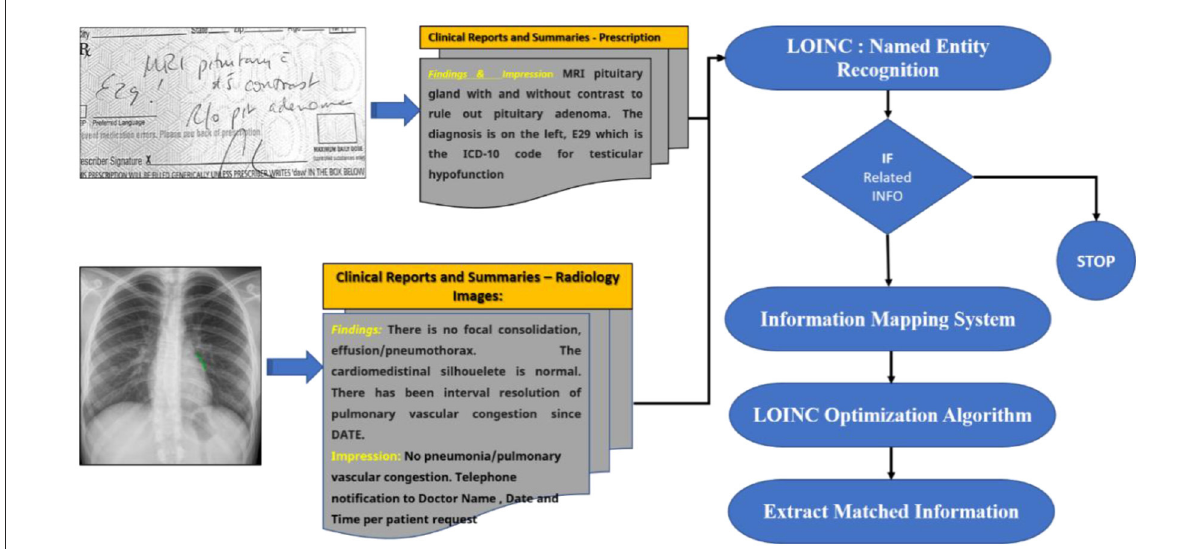
FIGURE6 A proposed model for extracting patient treatment features from MedIMG.